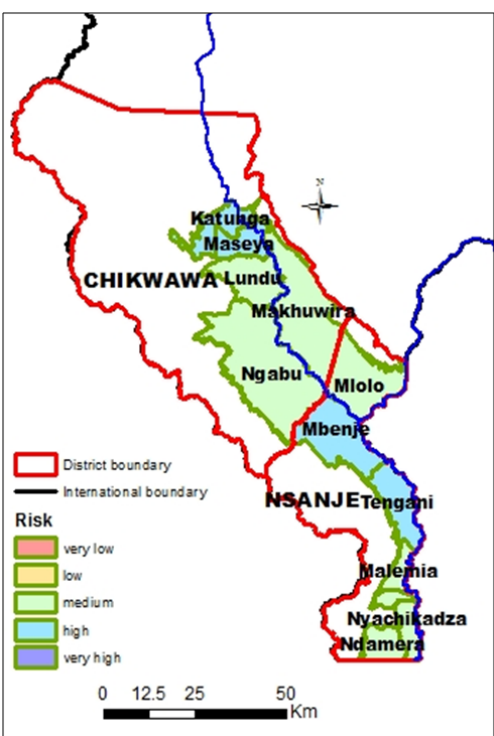
Figure 4. Spatial variation in risk in the Lower Shire